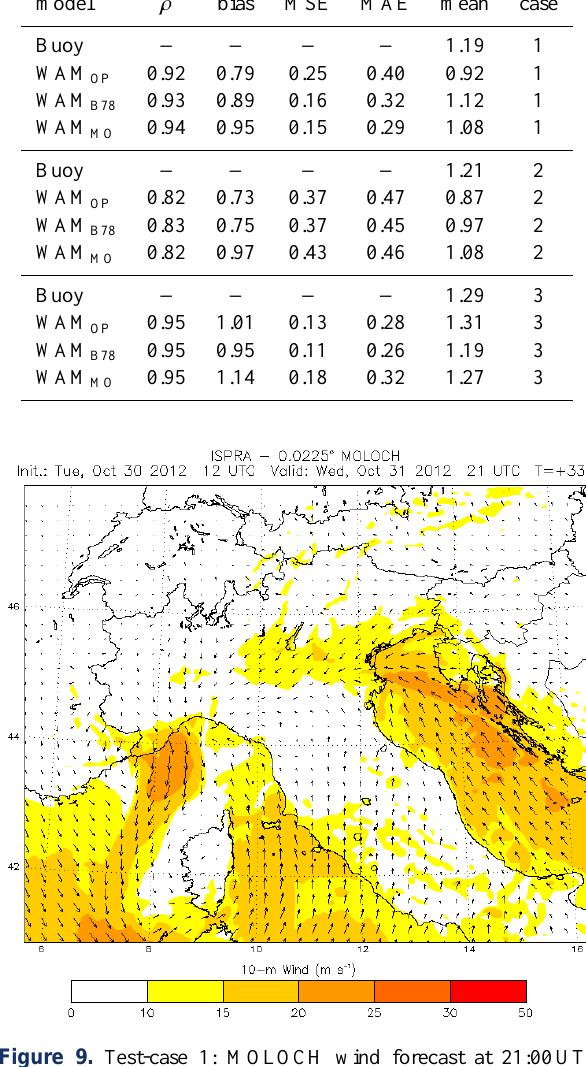
Figure 9. Test-case 1: MOLOCH wind forecast at 21:00UTC 31 October 2012, initialized at 12:00UTC 30 October 2012 using 0.07 ◦ BOLAM